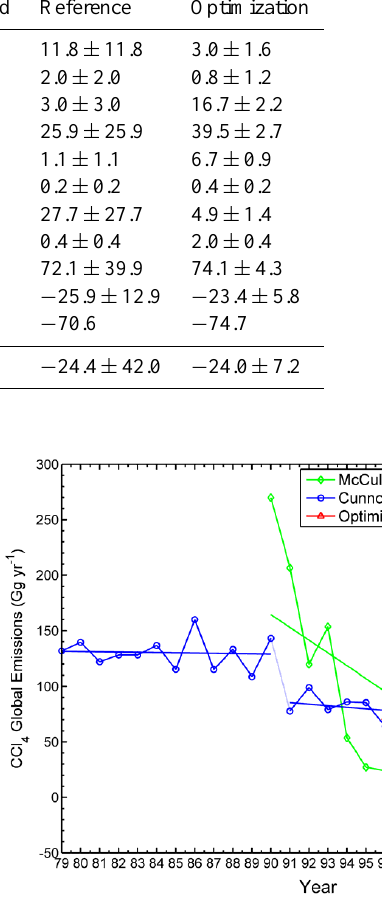
Fig. 2. Yearly global industrial emission estimates for CCl 4 from the industrial sales data (McCulloch, private communication, 2009) and from the 2-D model inverse modeling approach (Cunnold et al., 1997; Simmonds et al., 1998; updated to 2004), with the corresponding linearly fitted emissions. There are two regimes in the 2-D model emission estimates, and the linearly fitted yearly global emissions for 1996-2004 are used as our reference (a priori) values. Also shown are the a posteriori global annual emission estimates with the linearly fitted emissions.